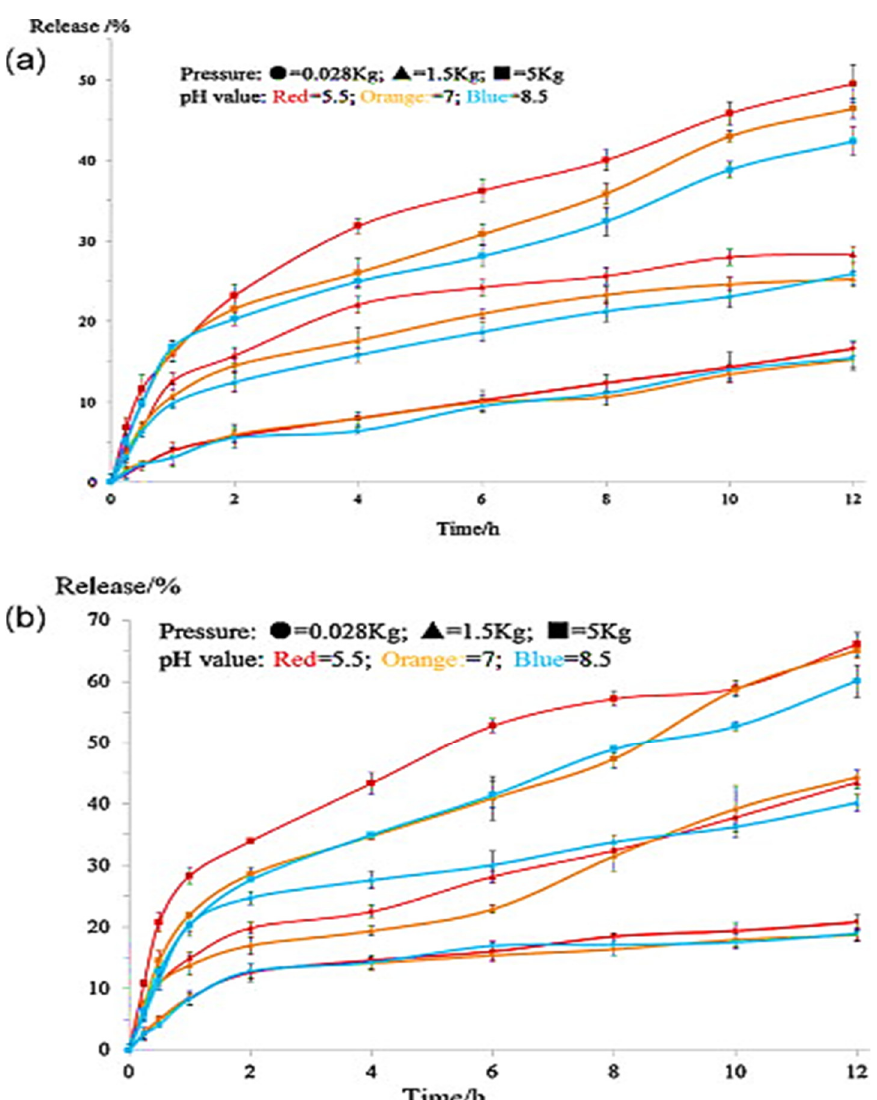
Figure 29. Quantity of ( a ) chitosan/miconazole nitrate and ( b ) chitosan/clotrimazole microspheres released in vitro from the drug at diverse pressures at various concentrations. Reproduced with permission from [332].